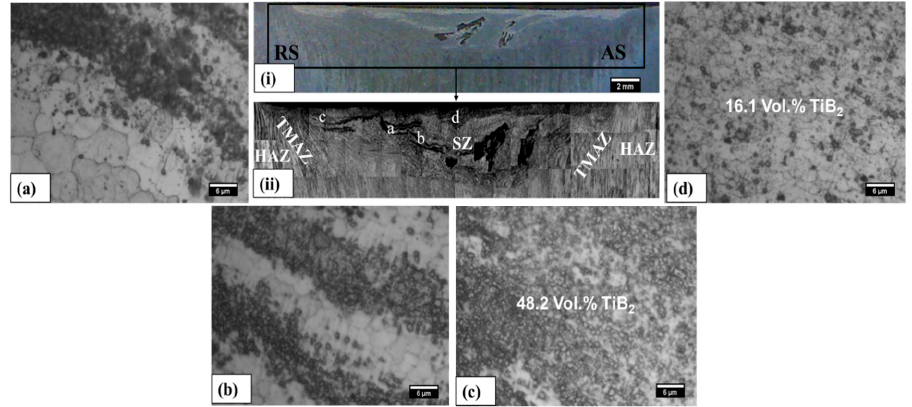
Figure 14. ( i ) Macro-image of cross-section of Sample 8. ( ii ) Microstructure of cross-section of the rectangle in macro-image showing: ( a ) RS reinforced zone interface; ( b ) mixed and unmixed region; ( c ) mixed region; and ( d ) dispersed region.